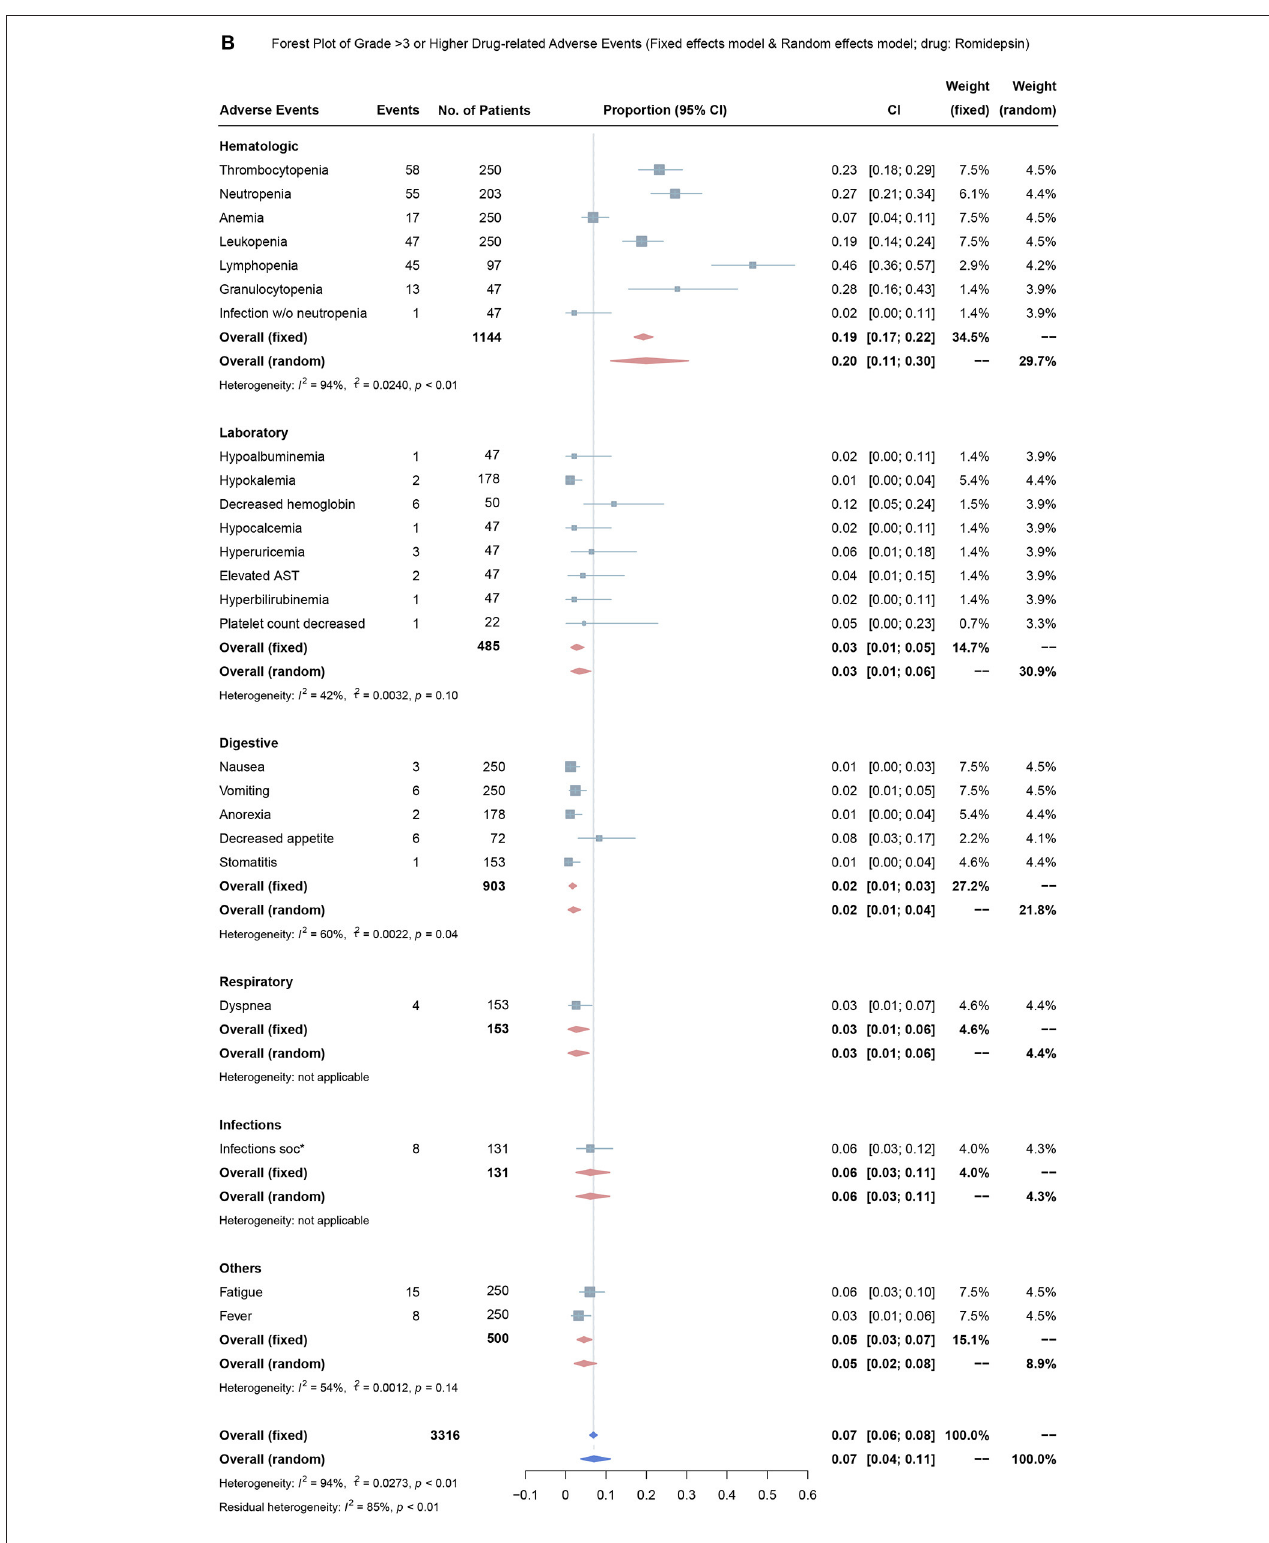
FIGURE 4 | Forest plots for over proportion of adverse events in treatment with romidepsin. (A) Proportion of all-grade adverse events in treatment with romidepsin; (B) Proportion of grade 3 or higher adverse events in treatment with romidepsin. ALT, alanine aminotransferase; AST, aspartate aminotransferase.